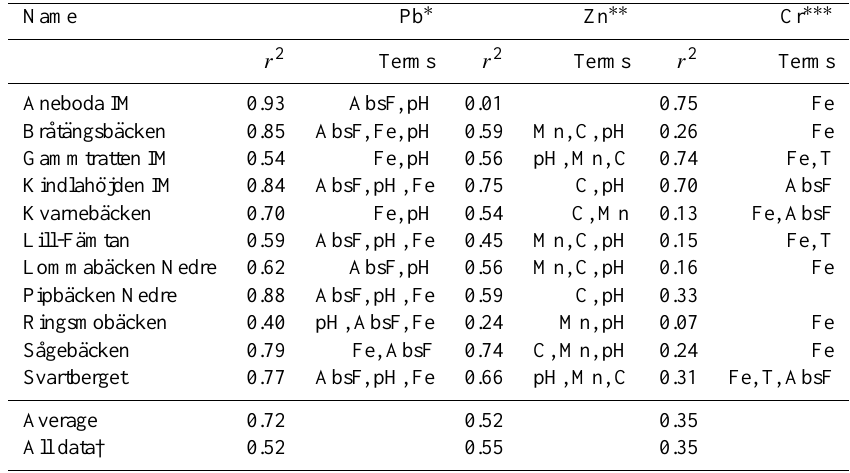
Table 5. Step-wise multiple linear regression models and variance explained ( r 2 ) by site and using all data. Statistically significant variables are shown in order of importance (absolute value of the